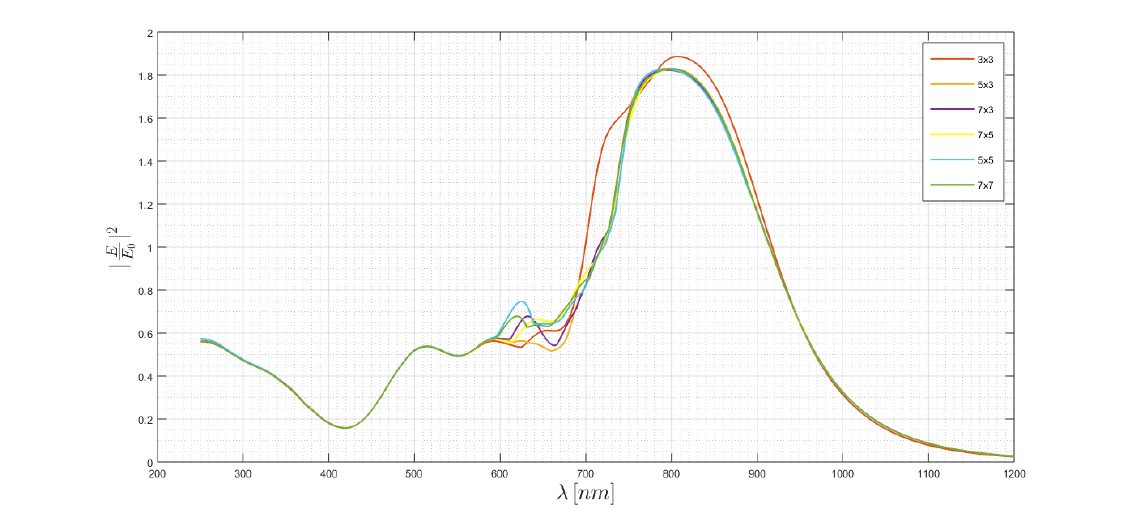
Figure 15. Sweep of the number of holes that composed the silver